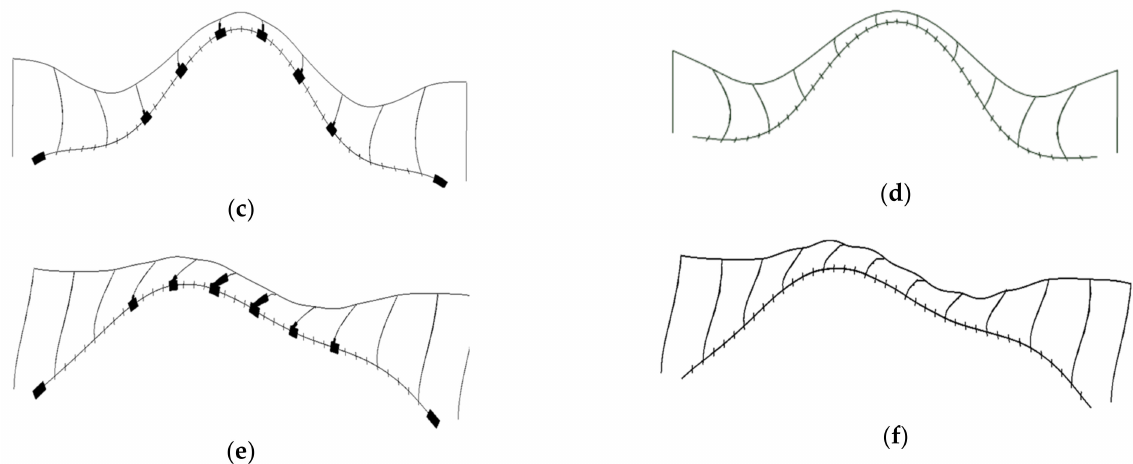
Figure 10. In-plane free-vibration modes of the bridge: ( a ) first-order mode obtained by hybrid element model; ( b ) first-order mode obtained by beam element model; ( c ) second-order mode obtained by hybrid element model; ( d ) second-order mode obtained by beam element model; ( e ) third-order mode obtained by hybrid element model; ( f ) third-order mode obtained by beam element model.